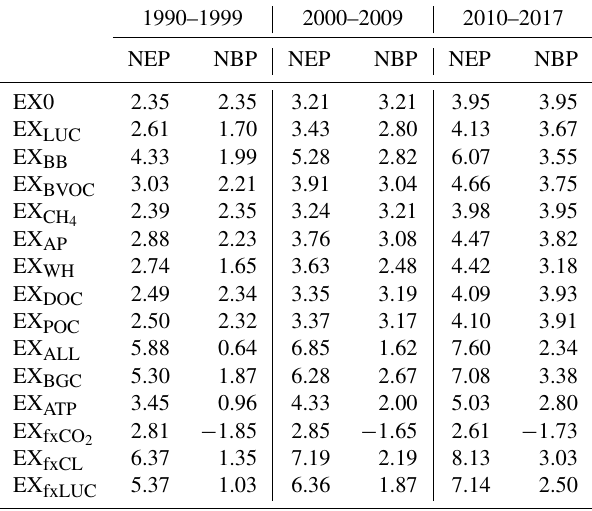
Table 1. Decadal summary of simulation results of net global ter- restrial carbon budget (Pg Cyr − 1